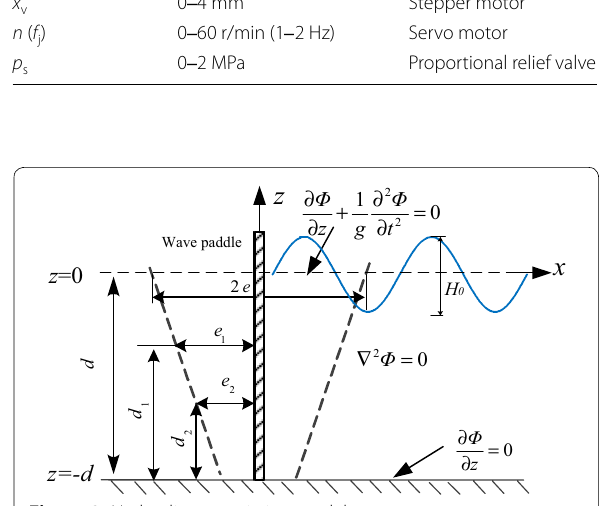
Figure 3 Hydraulic transmission model